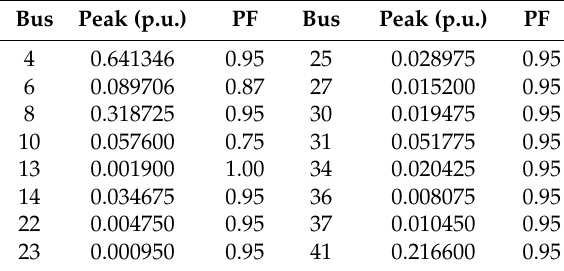
Figure 5. Network for the case study. Table 2. Demand daily peak and power factors.